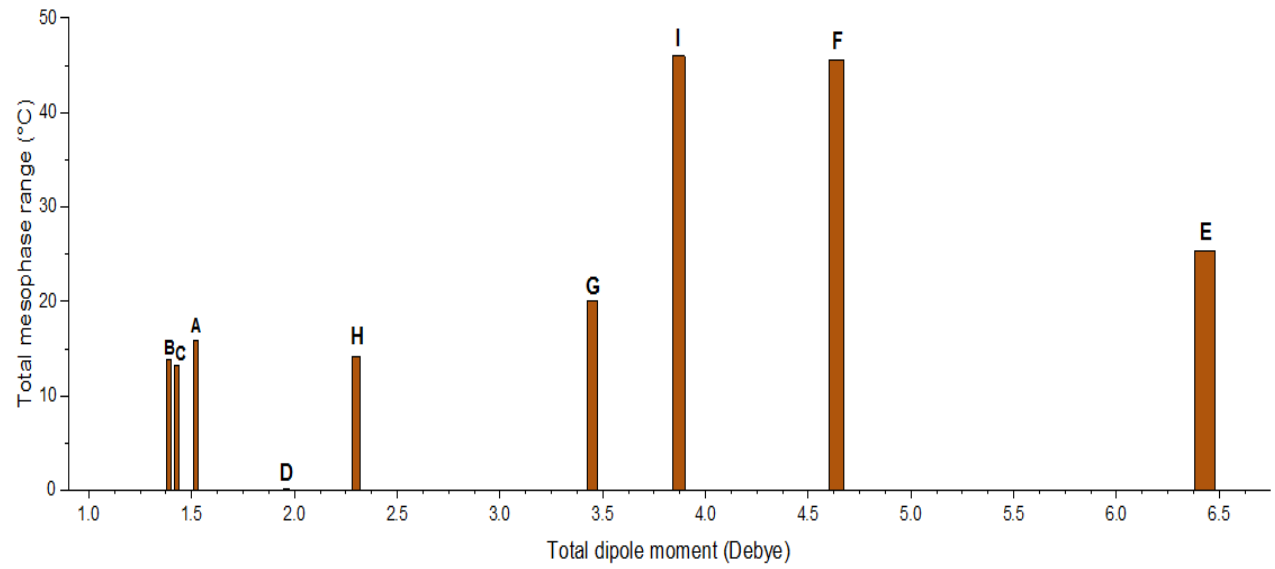
Figure 7. Graph of mesophase range versus total dipole moment of A , B , C , D , E , F , G , H , and I compounds.